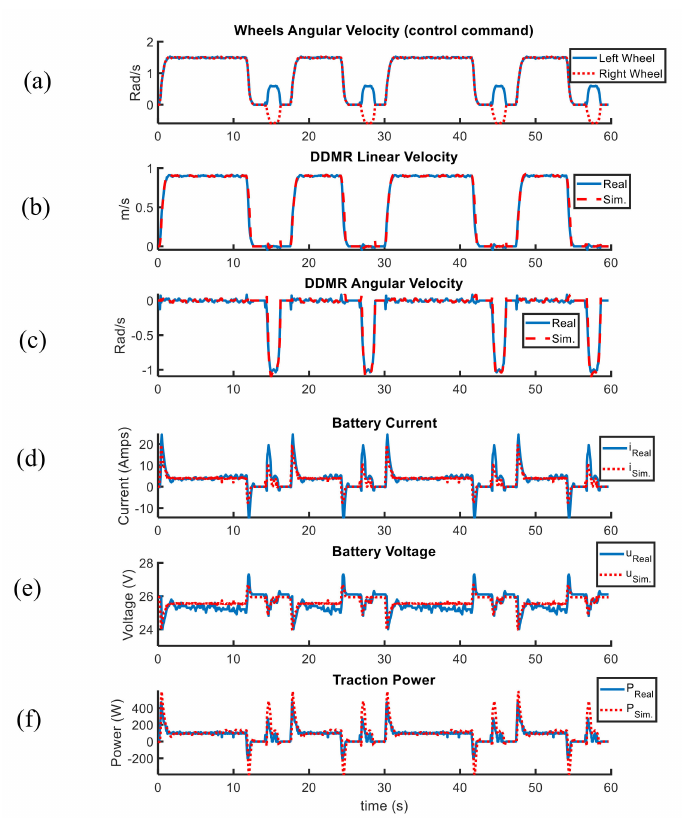
Figure 10. Comparison results of experimental data from physical DDMR versus the model. ( a ) Wheels speed ( b ) linear speed, ( c ) angular speed, ( d ) battery voltage, ( e ) battery current, and ( f ) traction power.